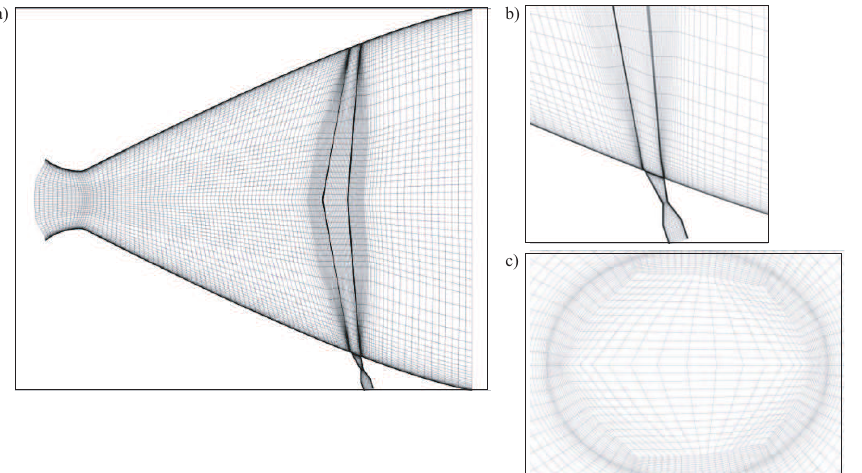
Figure 9. Computational mesh ( a ), mesh near injection port ( b ) and mesh in cross section of the injection port ( c ) with l j = 0.7, α j = 130 ◦ , d 2 / d 1 = 0.6, A ∗ / A a = 0.1.